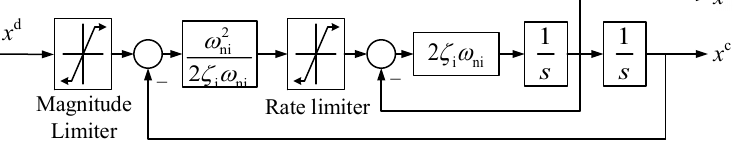
Figure 5. Structure of command